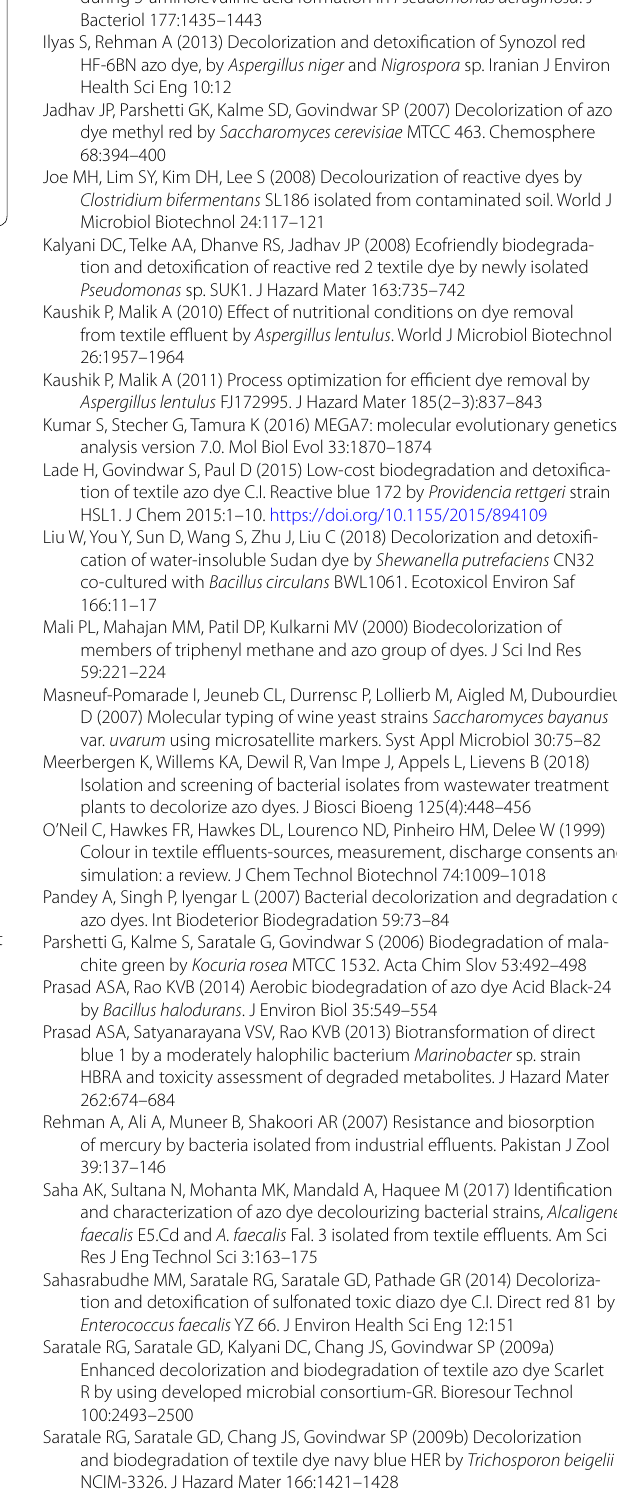
Additional file 1: Table S1. Decolorization (%) of bacteria isolated from 3 industrial samples. Figure S1. Growth of A. aquatilis 3c at various (a) temperature and (b) pH after incubation of 16 h. Figure S2. Growth of A. aquatilis 3c in LB medium. Optical density was taken at 600 nm after regular time interval. Figure S3. Phylogenetic tree constructed through MEGA7 to show homology of A. aqualitis 3c with Alcaligenes sp. Figure S4. TLC chromatogram of extracted metabolites of A. aquatilis 3c decolor- ized dye samples visualize UV range of (a) 254 and (b) 366 nm. Figure S5. Chromatograms of extracted metabolites of A. aquatilis 3c decolorized dye sample through GC-MS